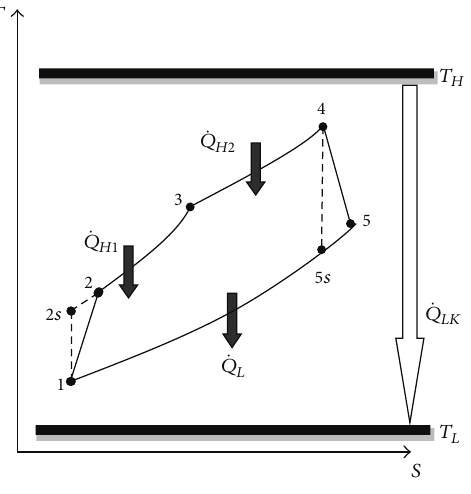
Figure 1: 𝑇 - 𝑆 schematic diagram for